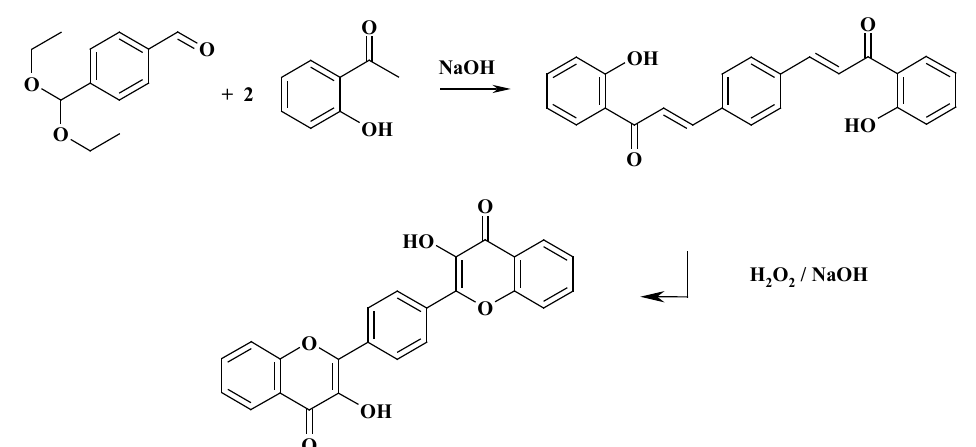
Figure 4. Synthesis of